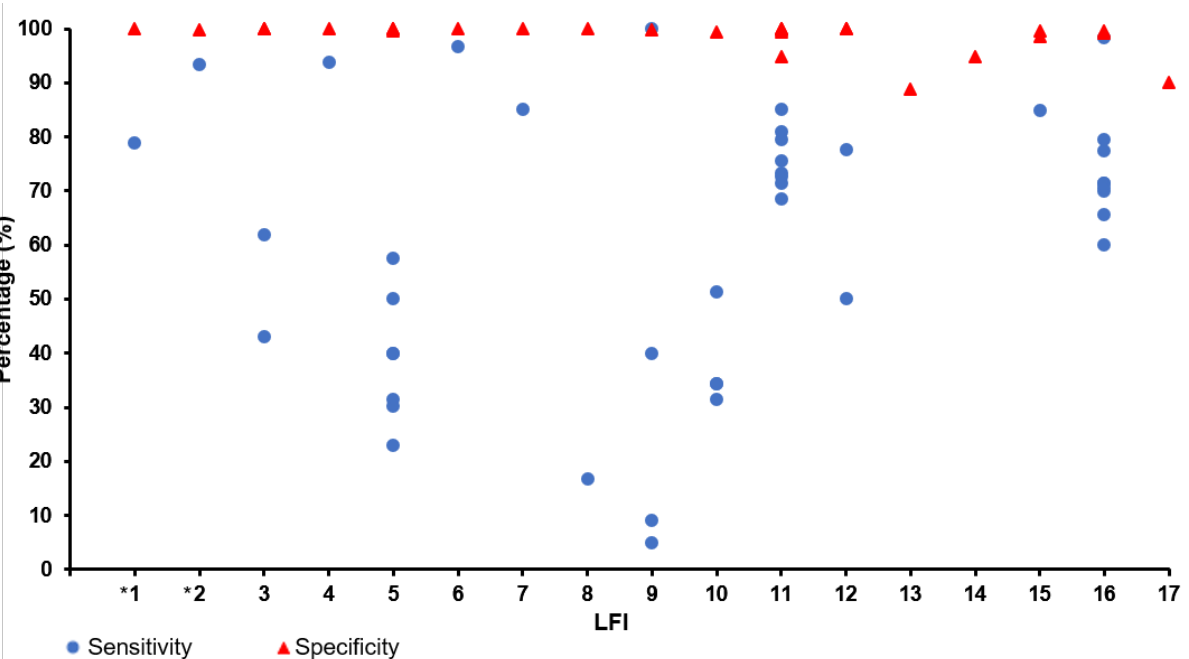
Figure 2. Sensitivity and specificity of commercial LFIs for the detection of SARS-CoV-2 antigen. ( 1 ). BD Veritor System for Rapid Detection of SARS-CoV-2 (VRD) (Becton, Dickinson and Company, Bergen, NJ, USA); ( 2 ). BinaxNOW COVID-19 Ag Card (Abbott Diagnostics, Chichago, IL, USA), ( 3 ). Biocredit COVID-19 Ag Detection Kit (RapiGEN, Anyang, South Korea); ( 4 ). Bioeasy 2019-Novel Coronavirus (2019-nCoV) Fluorescence Antigen Rapid Test Kit (fluorescence immunochromatographic assay) (Bioeasy Biotechnology, Shenzhen, China); ( 5 ). COVID-19 Ag Respi-Strip (Coris Bioconcept, Gembloux, Belgium); ( 6 ). COVID-VIRO (AAZ, Boulogne Billancourt, France); ( 7 ). Diagnostic Kit for 2019-nCoV Ag Test (Bioeasy Biotechnology, Shenzhen, China); ( 8 ). Huaketai New Coronavirus (Savant Biotechnology, Beijing, China); ( 9 ). Innova Lateral Flow Device (Innova Medical Group, Pasadena, CA, USA); ( 10 ). NADAL COVID-19 Ag Test (Nal Von Minden GmbH, Moers, Germany); ( 11 ). Panbio COVID-19 Ag Rapid Test Device (Abbott Rapid Diagnostics, Cologne, Germany); ( 12 ). Rapid antigen test provided by R-Biopharm; ( 13 ). Rapid COVID-19 Antigen Test (Healgen, Houston, TX, USA); ( 14 ). RIDA QUICK SARS-CoV-2 Antigen (R-Biopharm, Darmstadt, Germany); ( 15 ). SD Biosensor SARS-CoV-2 Rapid Antigen Test (Roche Diagnostics, Basel, Switzerland); ( 16 ). STANDARD Q COVID-19 Ag (SD Biosensor, Suwon-si, Republic of Korea); ( 17 ). StrongStep COVID-19 Antigen Test (Liming Bio-Products, Nanjing, China). * FDA-EUA.